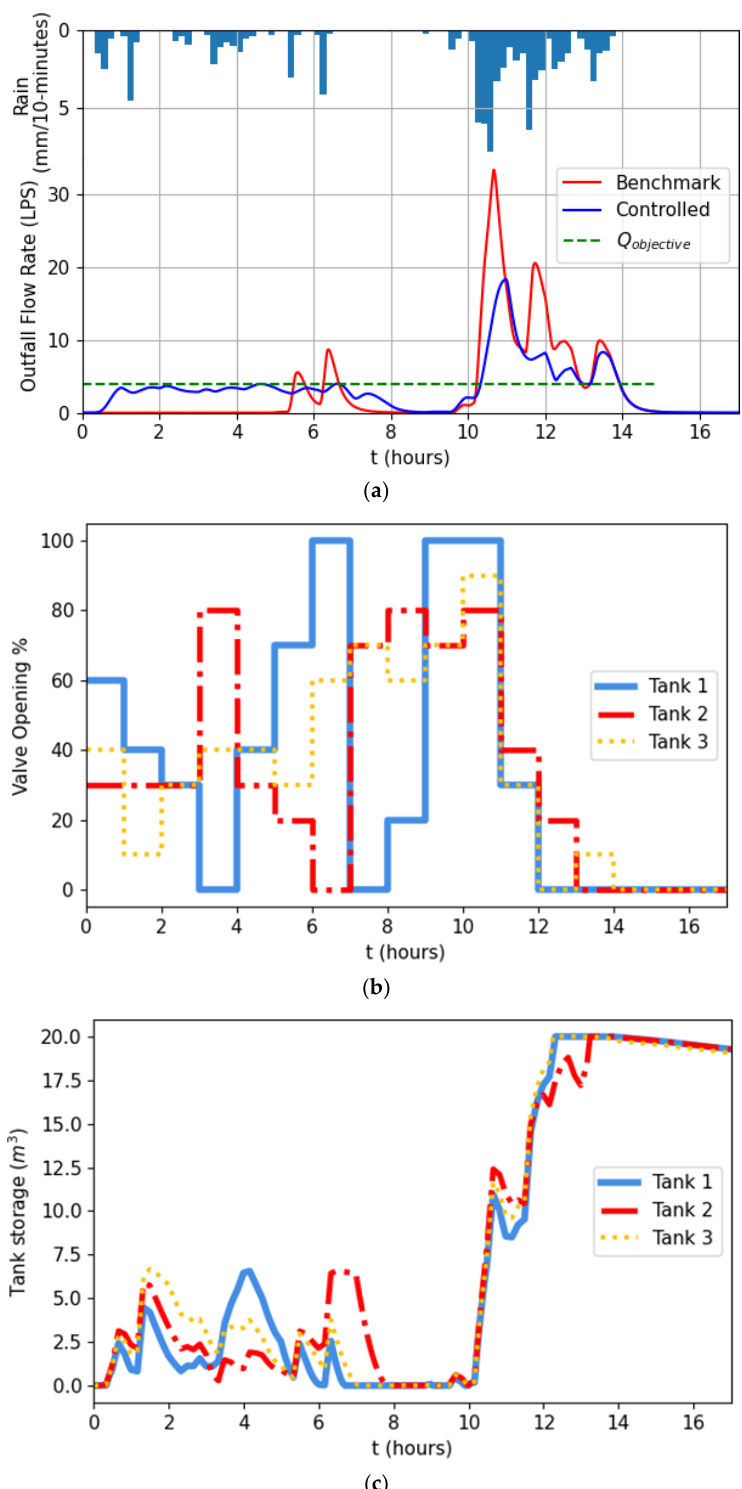
Figure 5. Results of applying the optimization process on a rain event recorded at Beit Dagan meteorological station on 5 January 2000. ( a ) Flow pattern of the benchmark run (no controlled releases—red) and from applying the optimized controlled release policy (blue). Q objective , which was used to evaluate the policy’s fitness according to Equation (5), is plotted in dashed green. ( b ) The control release policy, which was derived by applying the genetic algorithm—the degree of each valve’s opening during the simulated event. ( c ) Water stored in each tank during the simulated